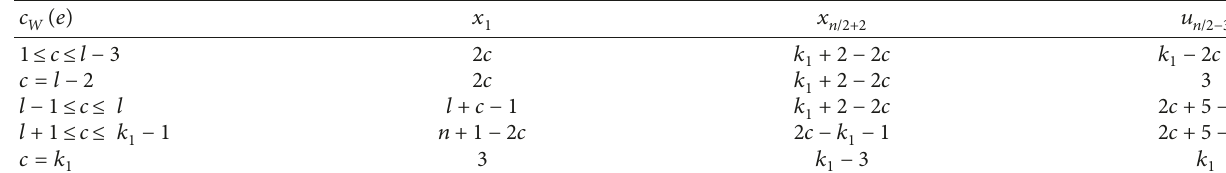
Table 37: Codes of edges, e � u